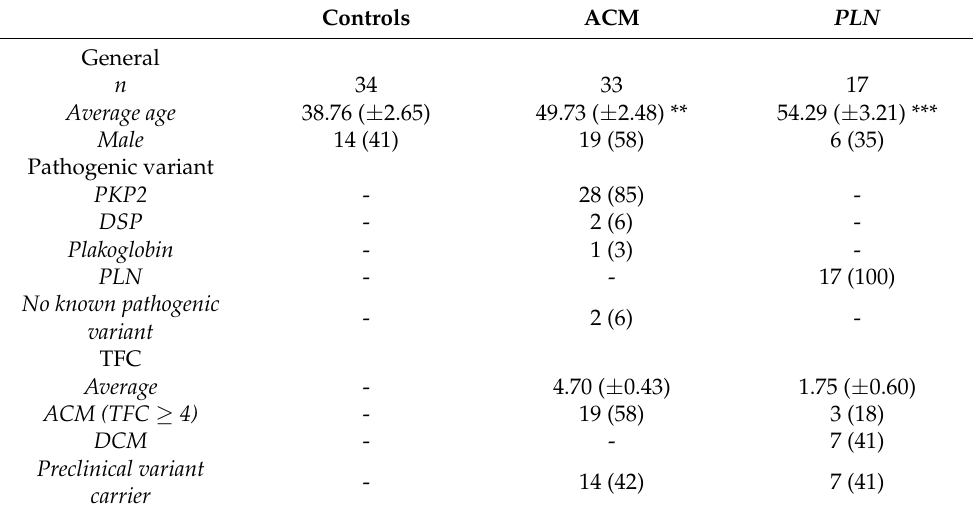
± standard error of the mean. PKP2; plakophilin 2, DSP; desmoplakin, PLN; phospholamban, TFC Task Force Criteria 2010, ACM; arrhythmogenic cardiomyopathy, DCM; dilated